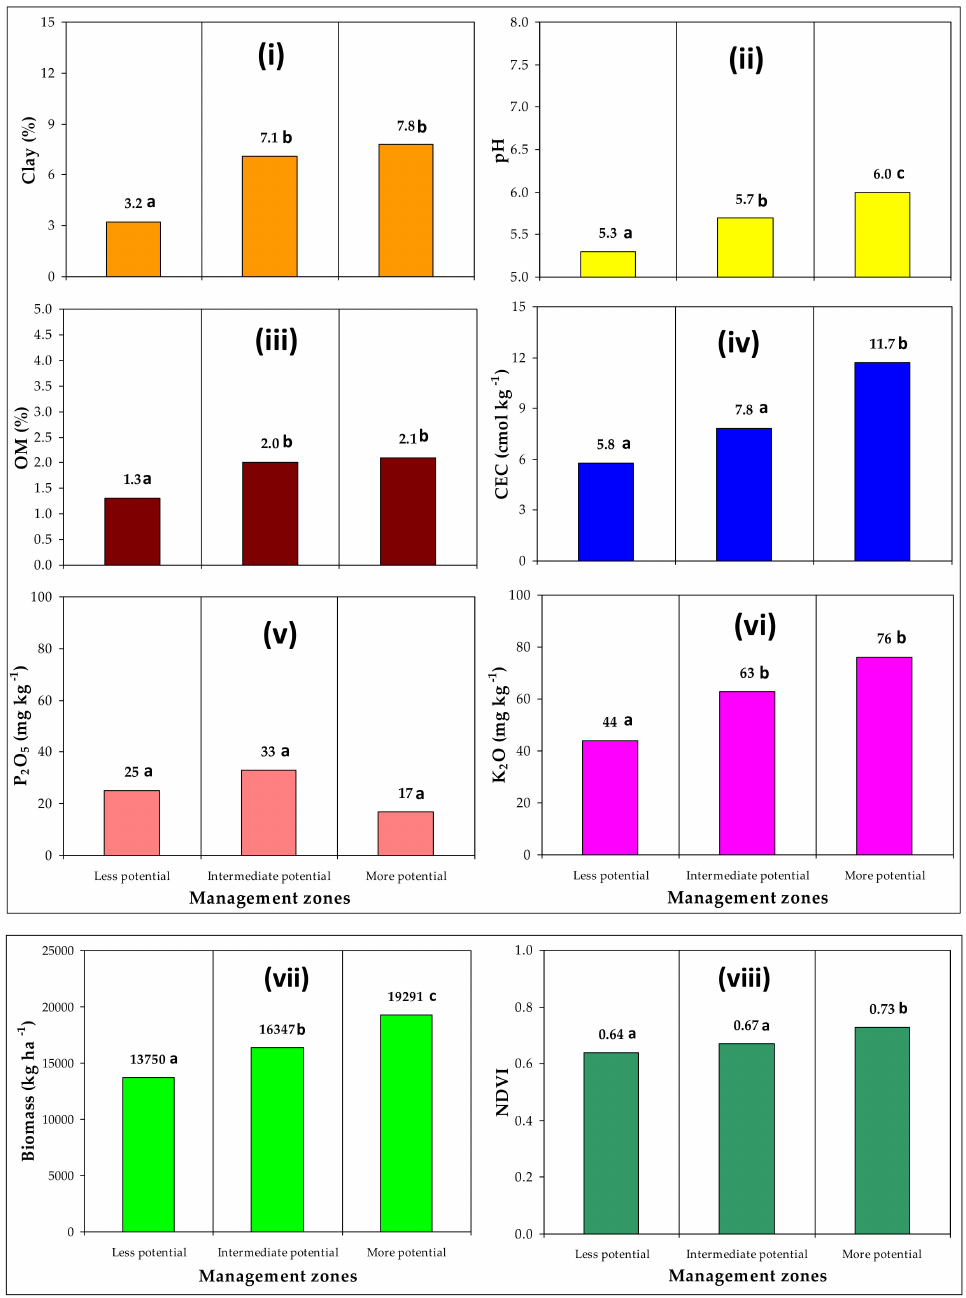
Figure 10. Homogenous management zones (HMZ) validation through soil ( i – vi ) and pasture ( vii , viii ) parameters. Different letters indicate significant